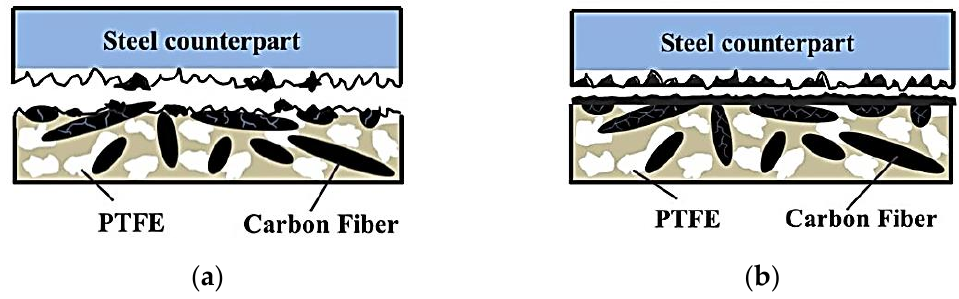
Figure 12. Schematic diagrams of TF formation for the ‘PPS + PTFE + SCF’ composites at loads of 200 ( a ) and 500 ( b ) N. Figure reproduced with permission from reference [76]. 200 ( a ) and 500 ( b ) N. Figure reproduced with permission from reference